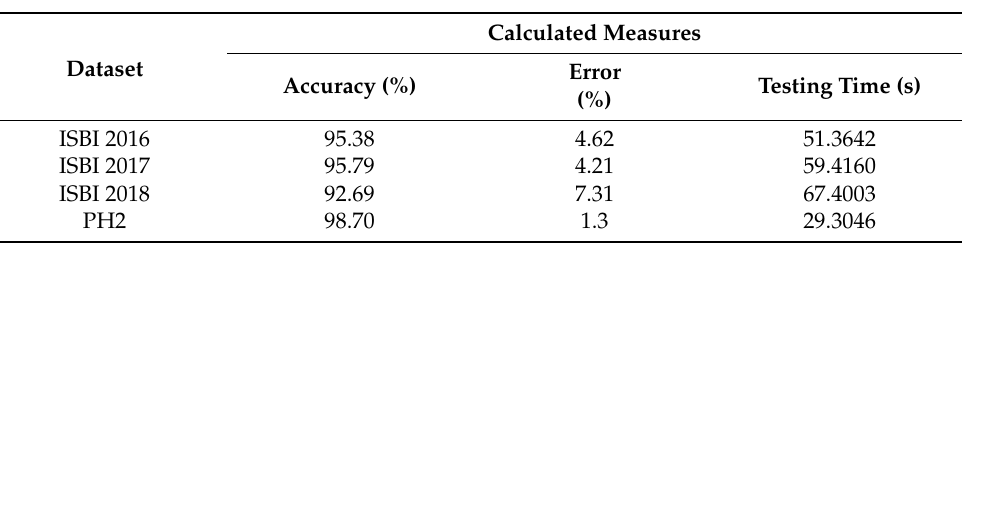
Table 1. Accuracy of the proposed lesion segmentation method by employing the contrast enhance- ment